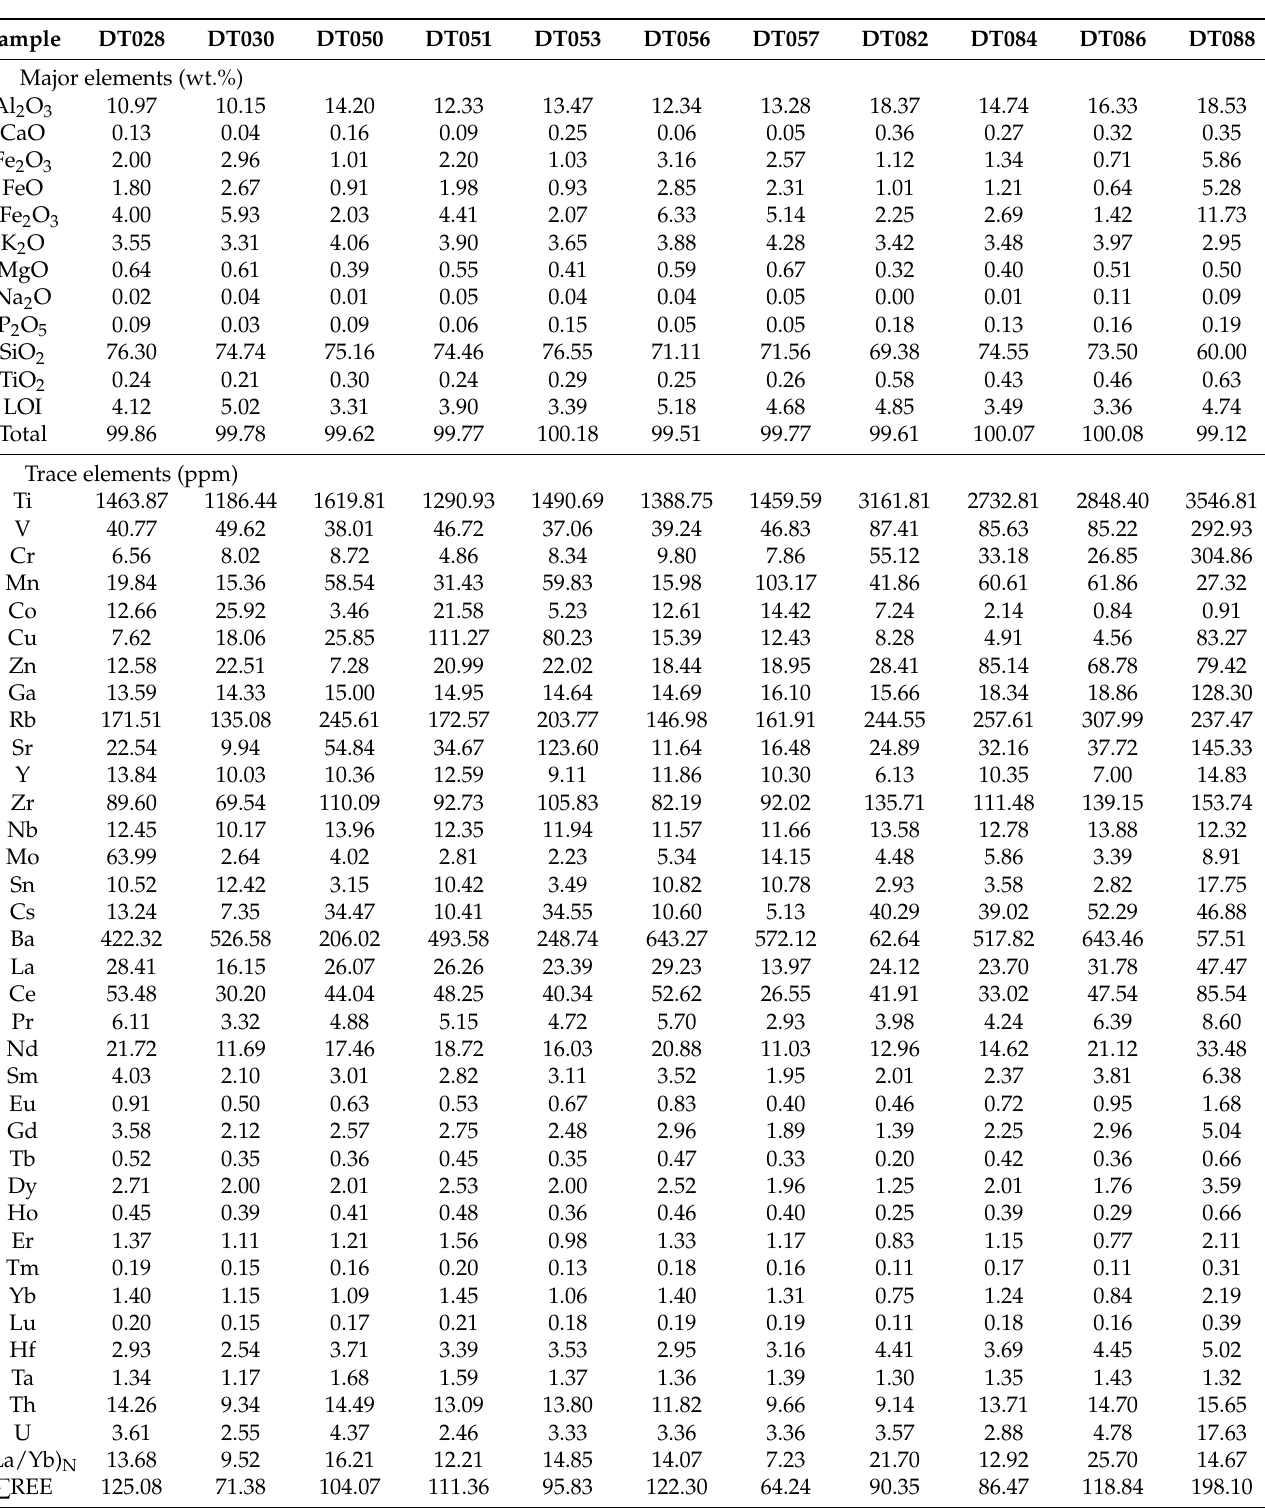
Table 1. Test data for major and trace elements of Dongxiang granodiorite